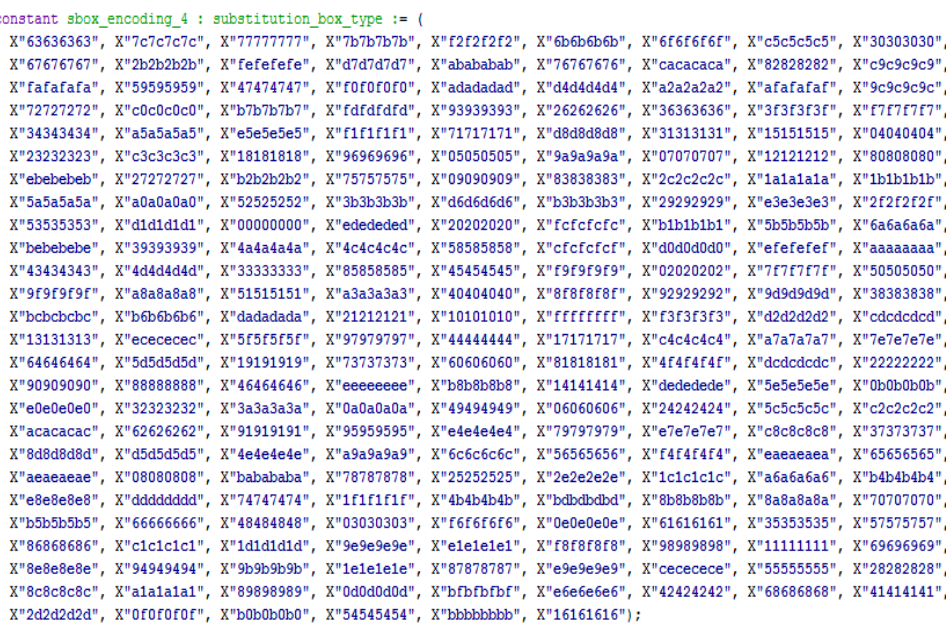
Figure 11. S-Box matrix containing 256 elements, each of 32 bit.